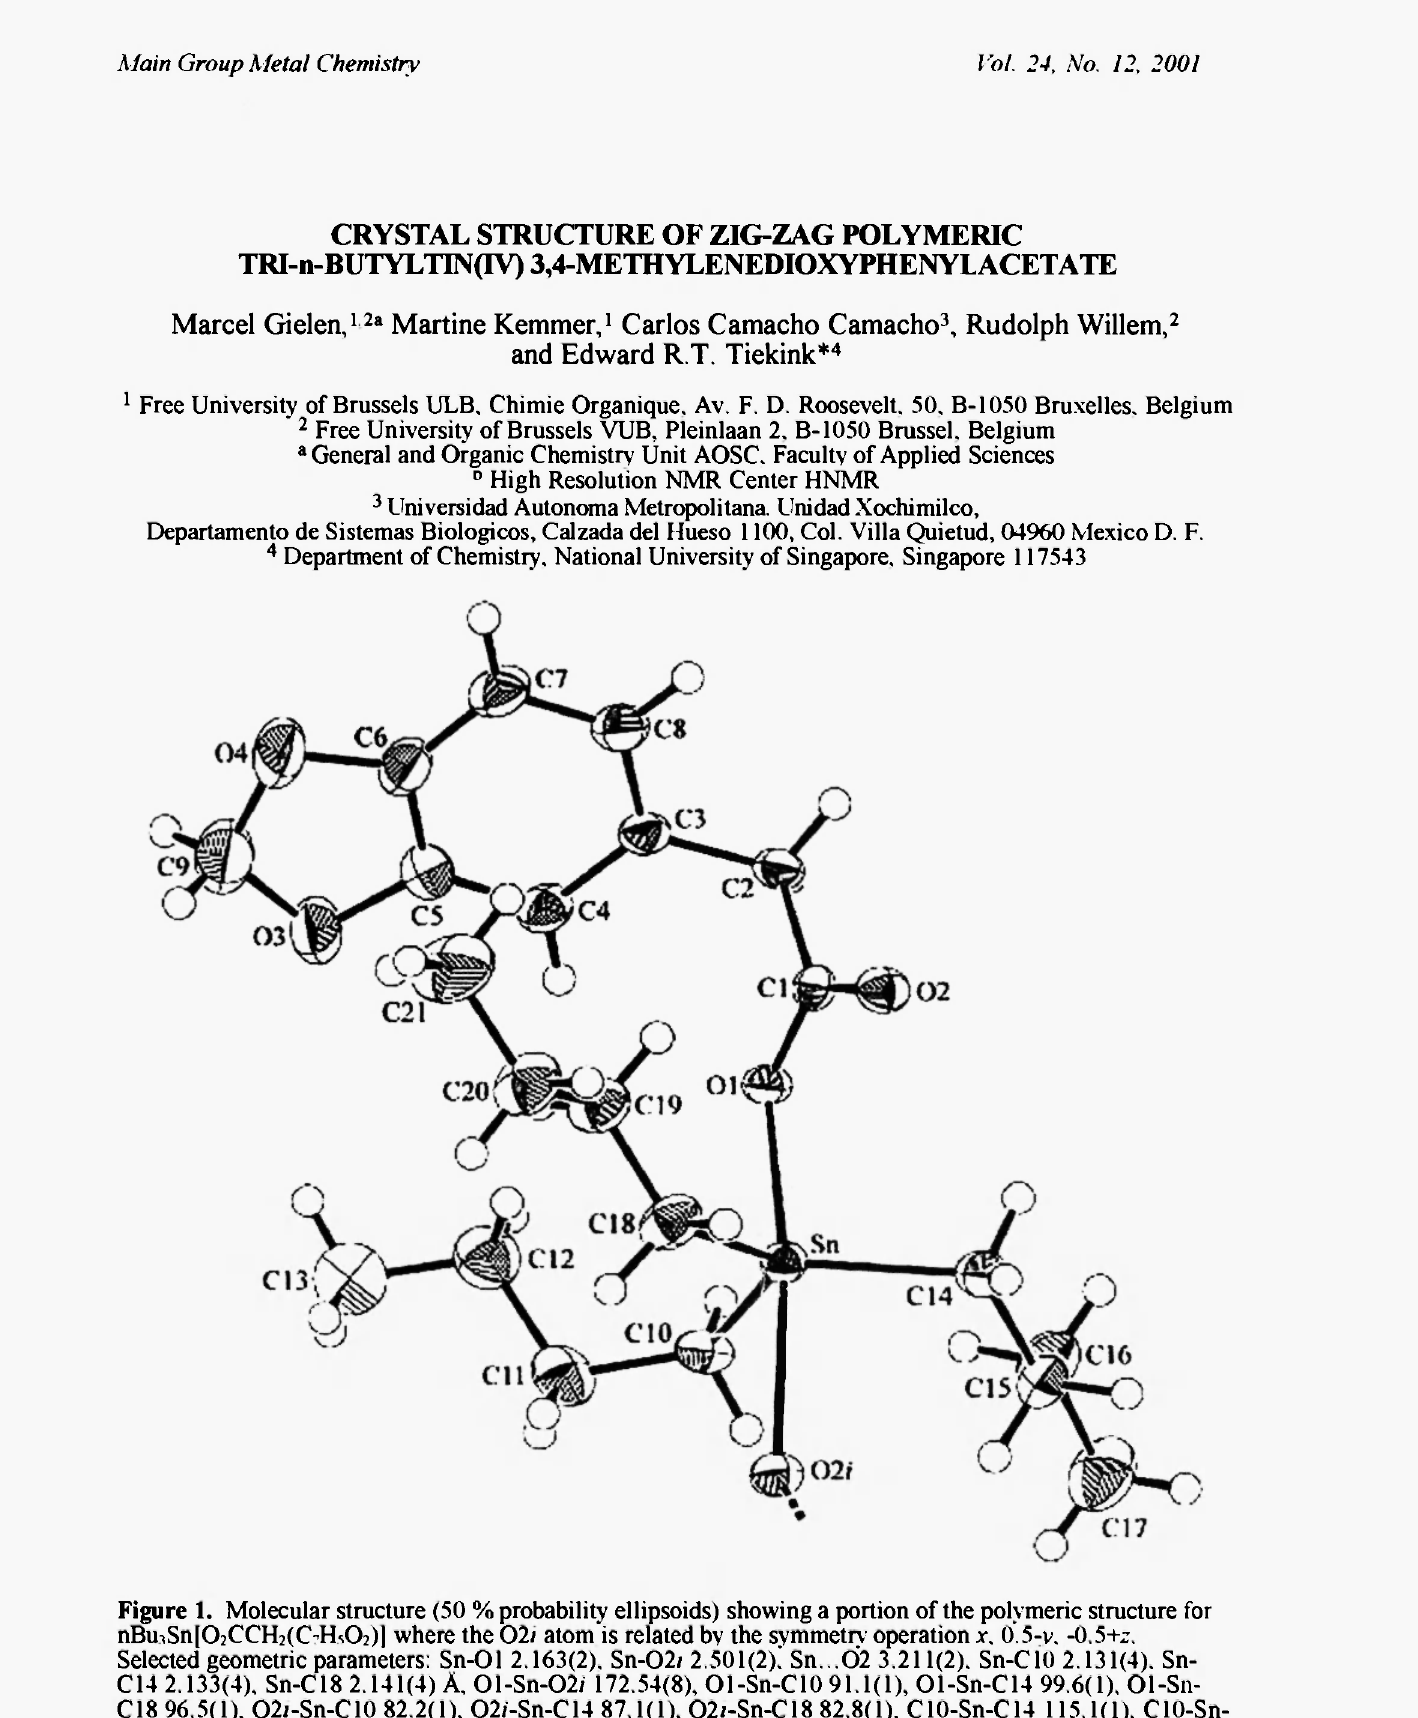
Figure 1. Molecular structure (50 % probability ellipsoids) showing a portion of the polymeric structure for nBuiSn[02CCH 2 (C-H^02)| where the 02/ atom is related by the symmetry operation x. 0.5-v. -0.5+2. Selected geometric parameters: Sn-Ol 2.163(2). Sn-02/ 2.501(2).' Sn...02 3.211(2). Sn-ClO 2.131(4).